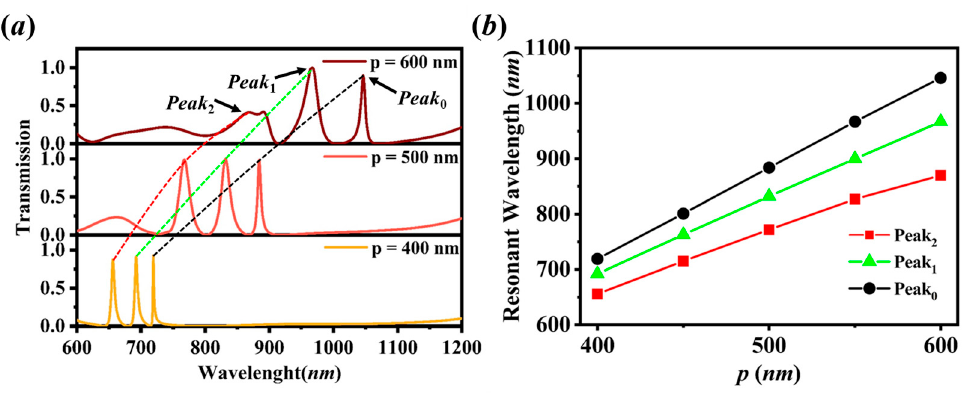
1.5 n  , 2 n  ) for various period p . ( b ) dependences of resonant L H Peak , Peak and Peak on period p . 0 1 2 n  ) for various period p . ( b ) dependences of resonant , 2 H Peak , Peak and Peak on period p . 0 1 2